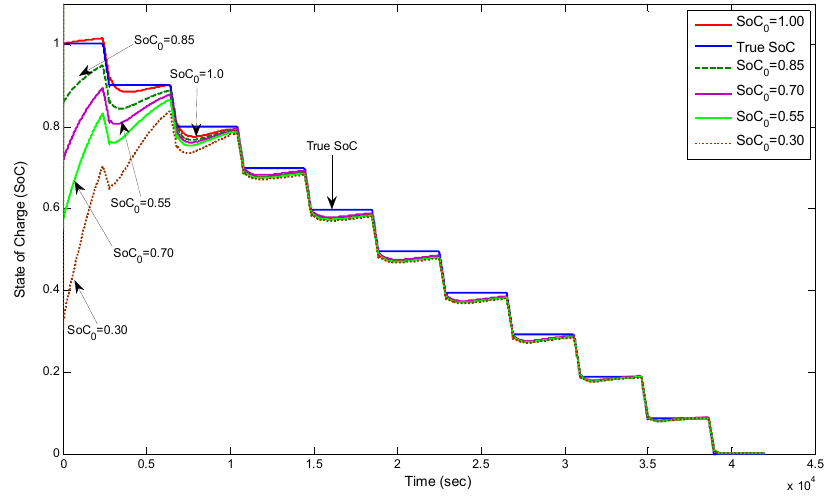
Figure 23. SOC curves for ARX(2,2) + EKF estimation with different initial SOC values ) (full view).